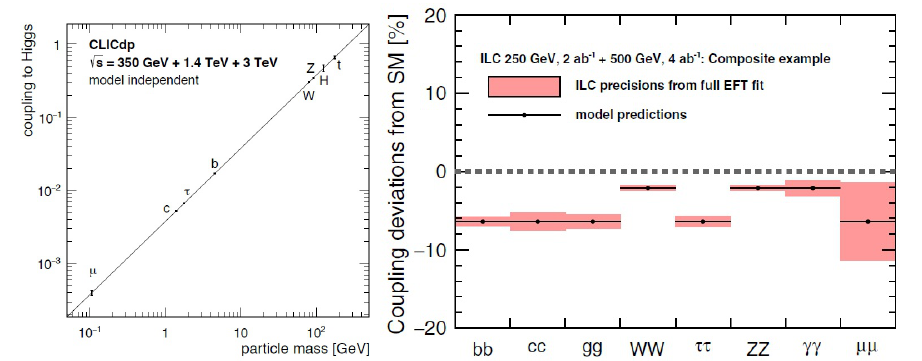
Figure 6. The precision of Higgs couplings, as expected by CLIC [23]). The solid line represents the SM prediction. Visualization of the deviations of Higgs couplings from the SM on the example composite Higgs model (right plot, from [22]) as estimated for the ILC [24].